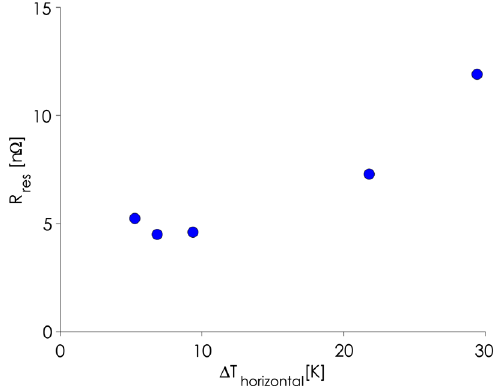
FIG. 10. Extracted residual resistance (at a field of 5 MV = m) as a function of the horizontal temperature difference, measured on a nitrogen doped cavity. Around 10 K, the effect of thermocurrents becomes noticeable.